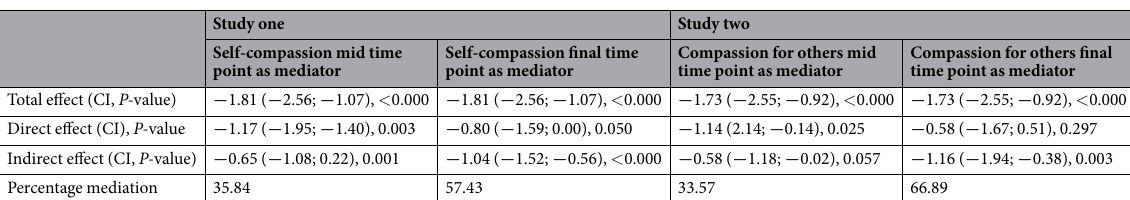
Table 2. Total, direct, and indirect effect estimates from the mediation